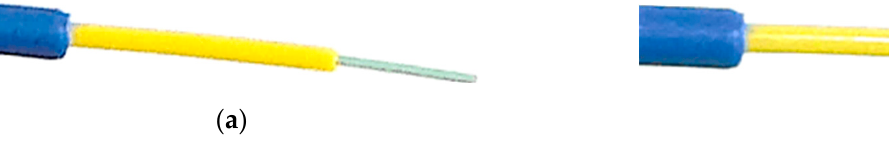
Figure 11. Layered cable with steel strengthening insert: ( a ) before the deformation; ( b ) after the permanent (plastic) deformation.